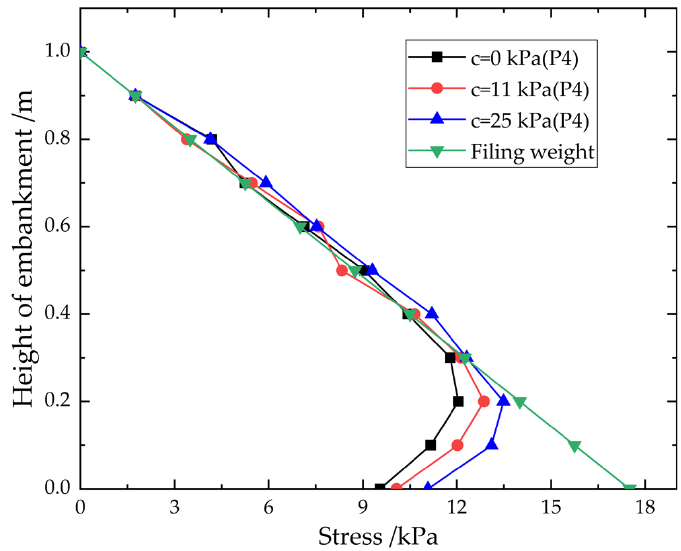
Figure 7. Effect of filling cohesion on Vertical stress in embankments.